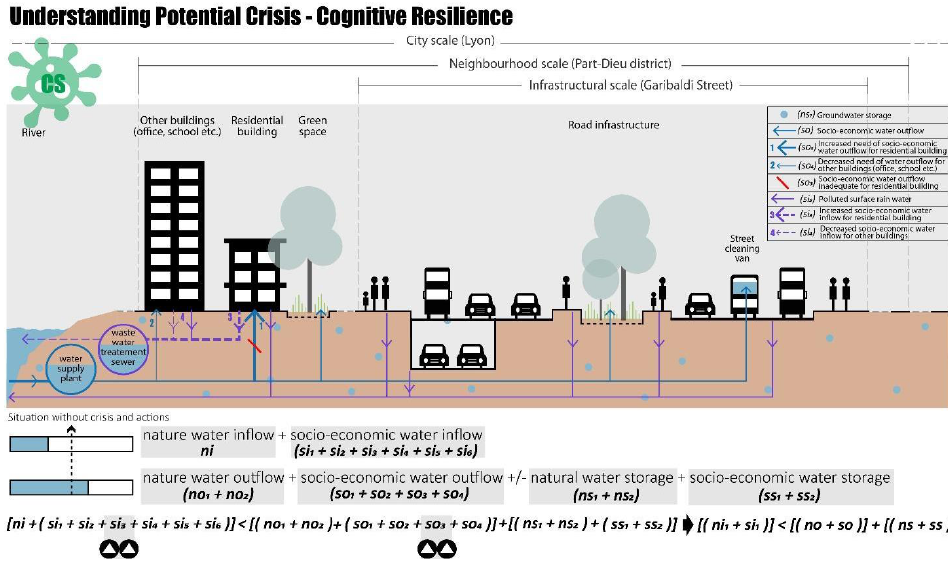
Figure 6. Cognitive resilience in Part-Dieu district, COVID-19 scenario, realised by